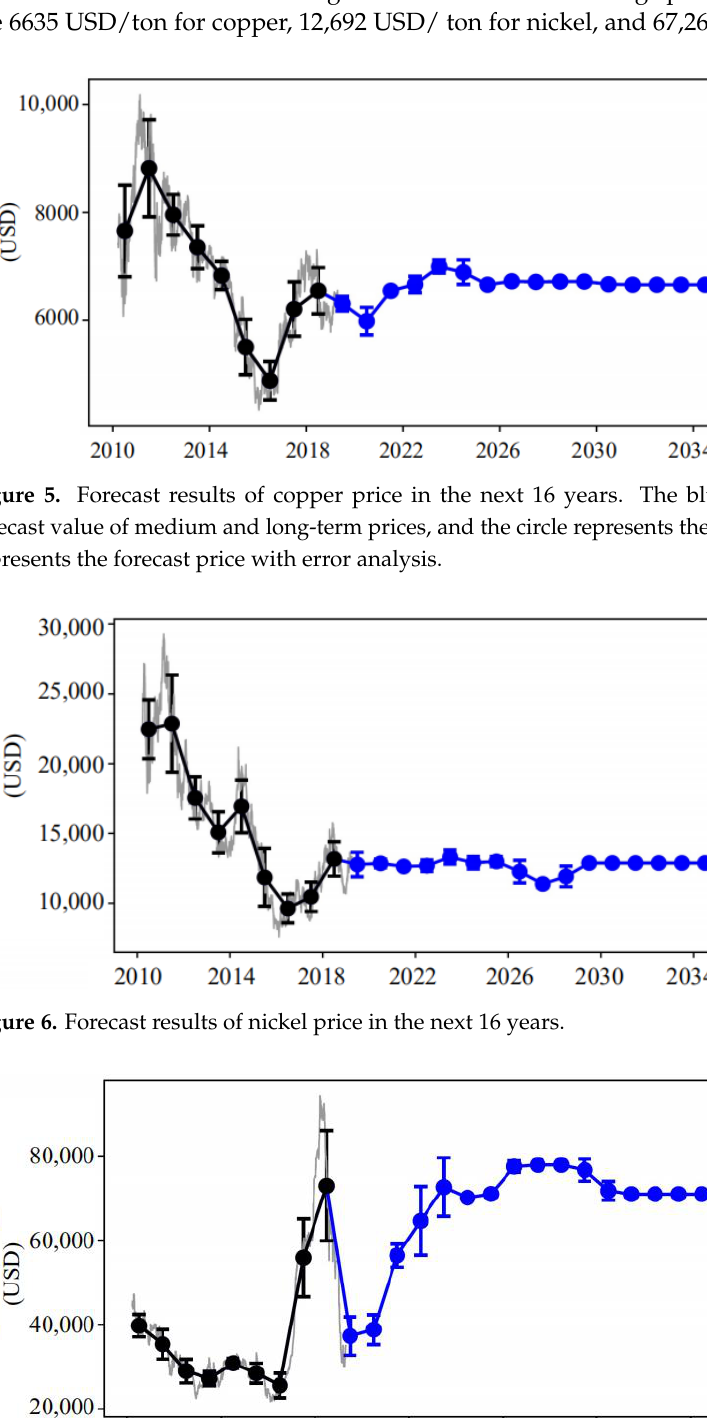
Figure 4. Comparison of predictive and actual cobalt price.